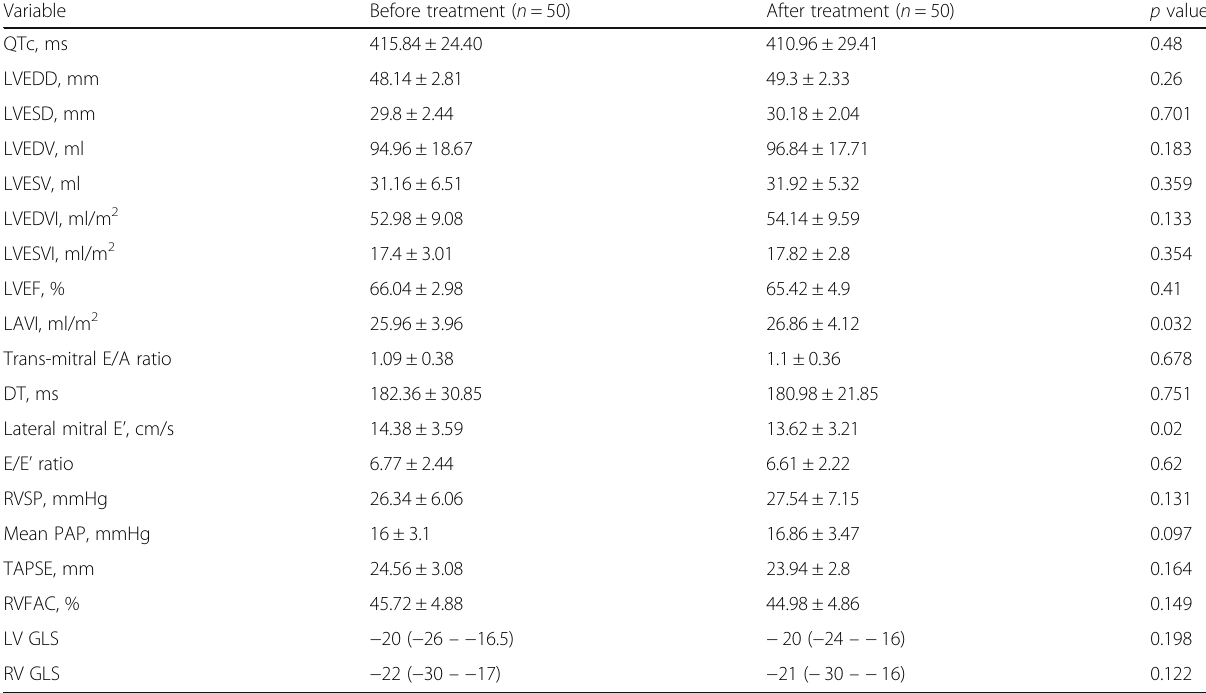
Table 3 Comparing ECG and echocardiographic variables in patients with liver cirrhosis before and after treatment Variable Before treatment ( n =